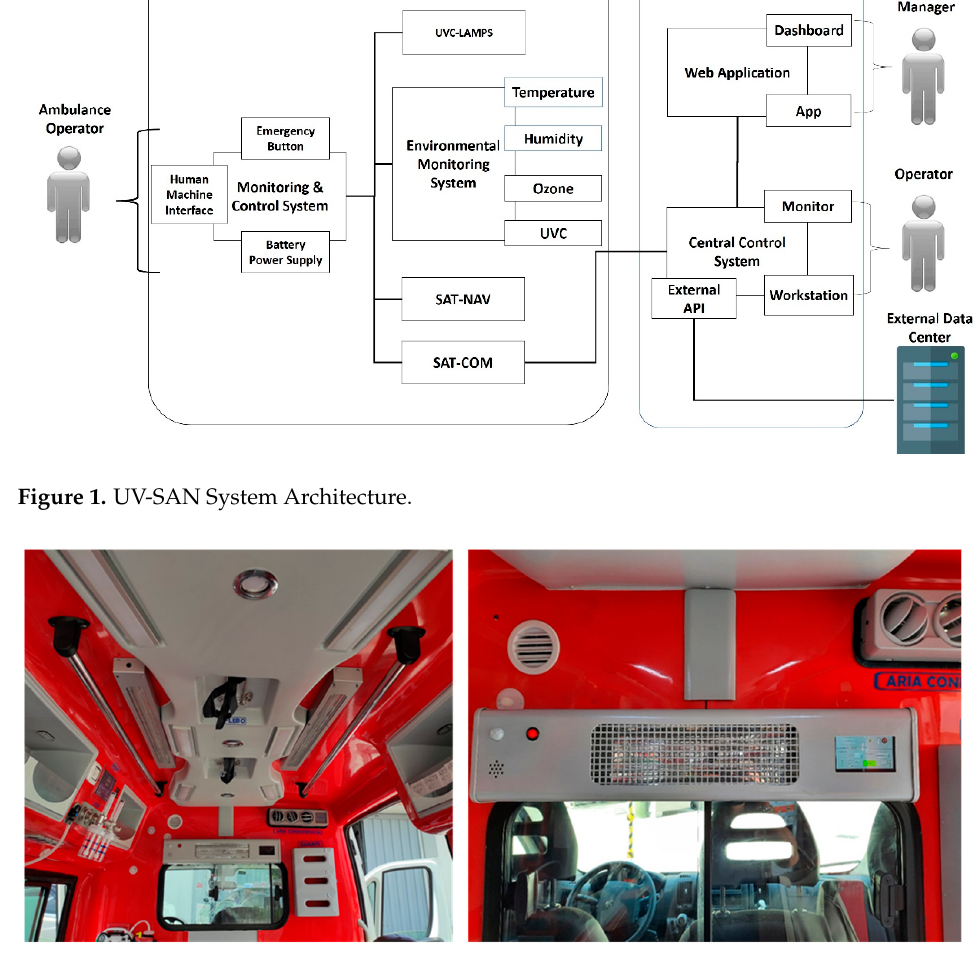
Figure 2. UV-SAN Sanitation Equipment installed in the ambulance patient compartment.